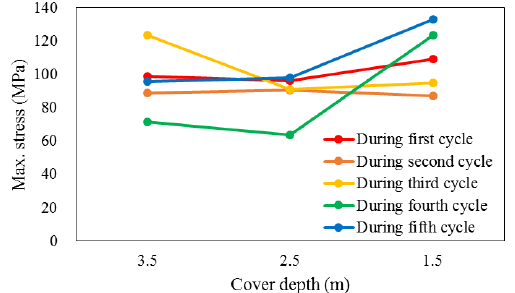
Figure 25. Maximum stress acting on pile during Stage 2 of each construction cycle based on cover depth.